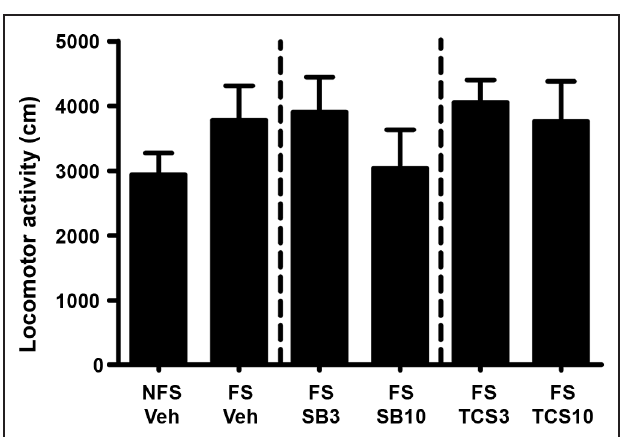
FIGURE 6 | Mean locomotor activity of all the groups in experiment 2. All data are expressed as mean ±